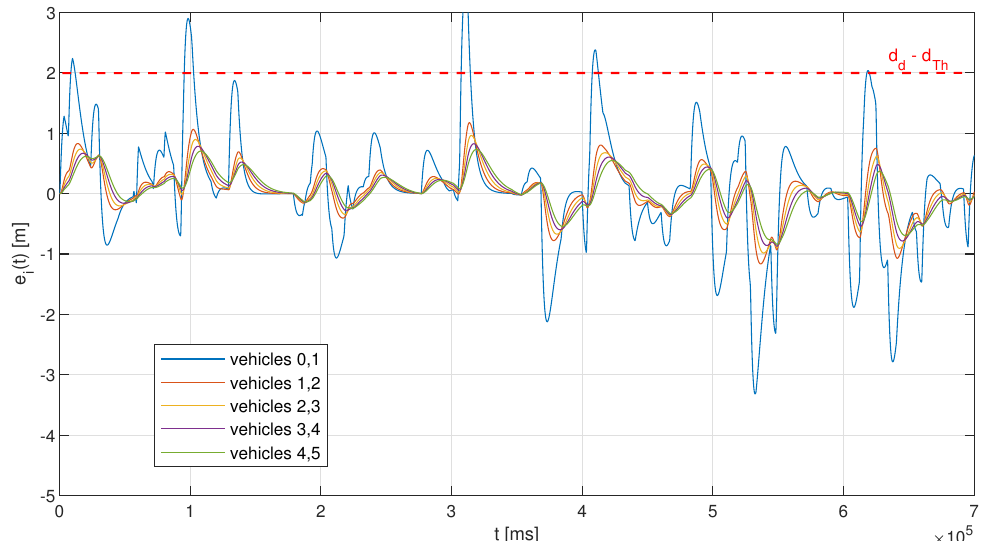
Figure 8. Example of inter-vehicle distance error evolution in a simulation run for fixed periodic transmission with ∆ t Tx = 500 ms; numbers in the legend represent vehicles’ positions in the platoon, with 0 indicating the leader, and 5 denoting the last vehicle (the tail of the